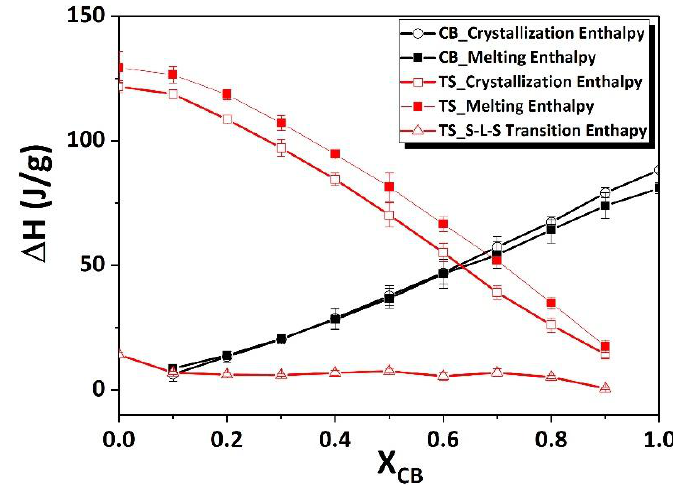
Figure 3. Enthalpy change of CB and TS during the crystallization and remelting process with respect to weight % of CB. black open square = crystallization, black filled square = remelting, red open square = crystallization, red filled square = remelting, open triangle = enthalpy change in S–L–S transition while remelting.